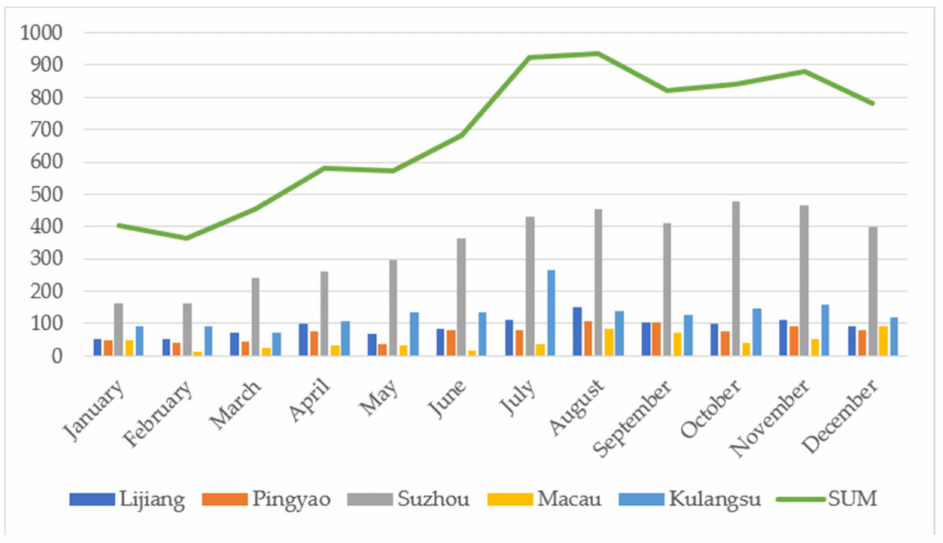
Figure 5. Monthly Weibo posts during the pandemic period in China (1 January 2020–1 January